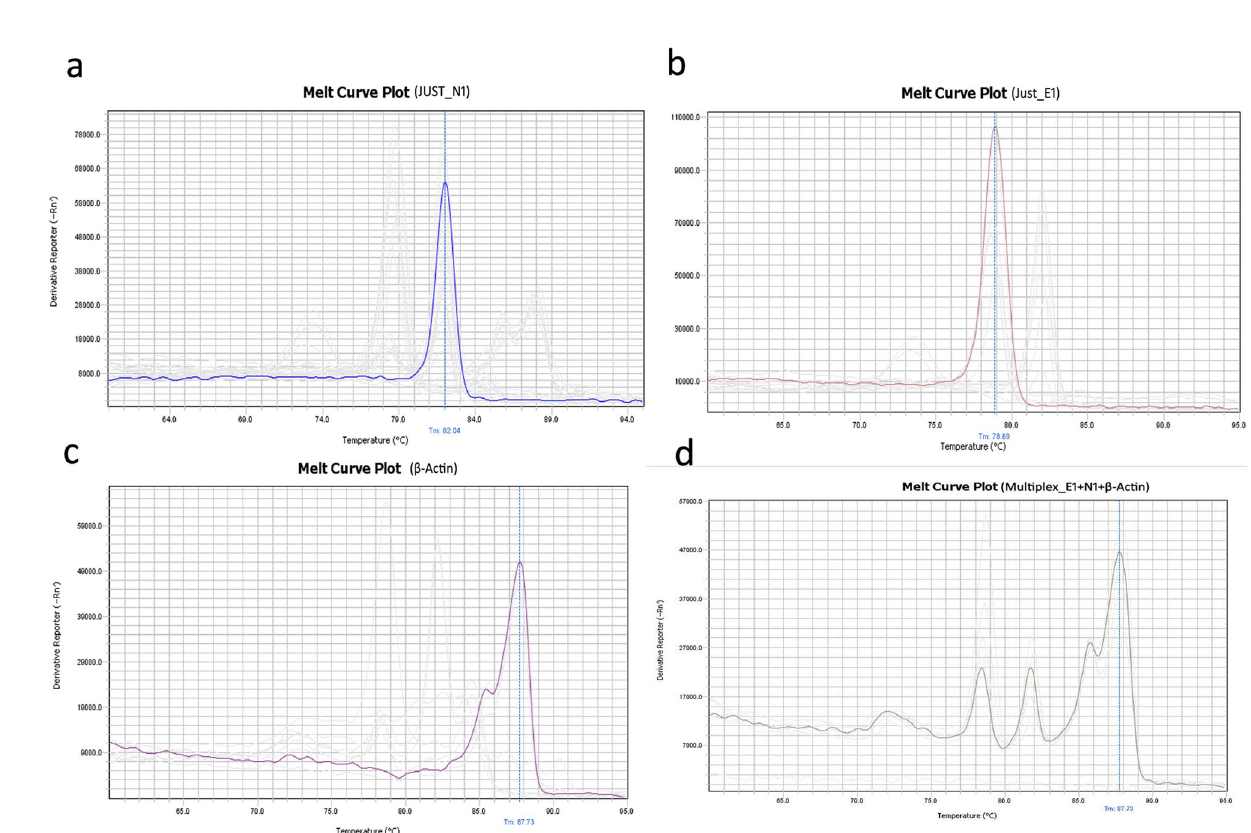
Figure 2. Melting curve plot of singleplex and multiplex assay. ( a ) Melting curve of N gene of COVID-19 Positive sample; ( b ) melting curve of E gene of COVID-19 Positive sample; ( c ) melting curve of Housekeeping gene β-Actin; ( d ) Melting Curve of Multiplex E + N + β-Actin genes of Covid-19 Positive